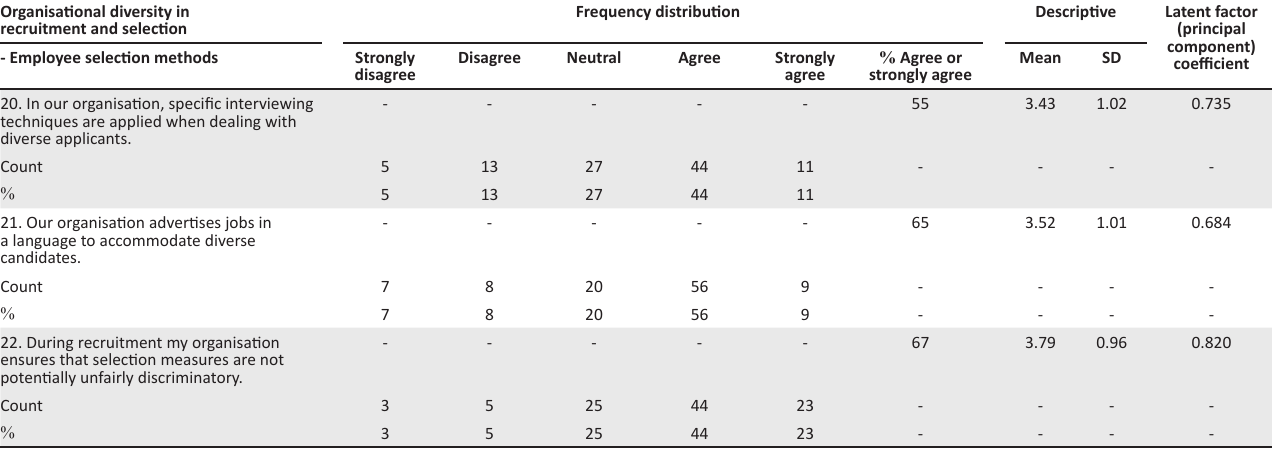
TABLE 7: Analysis of the sub-construct of employee selection